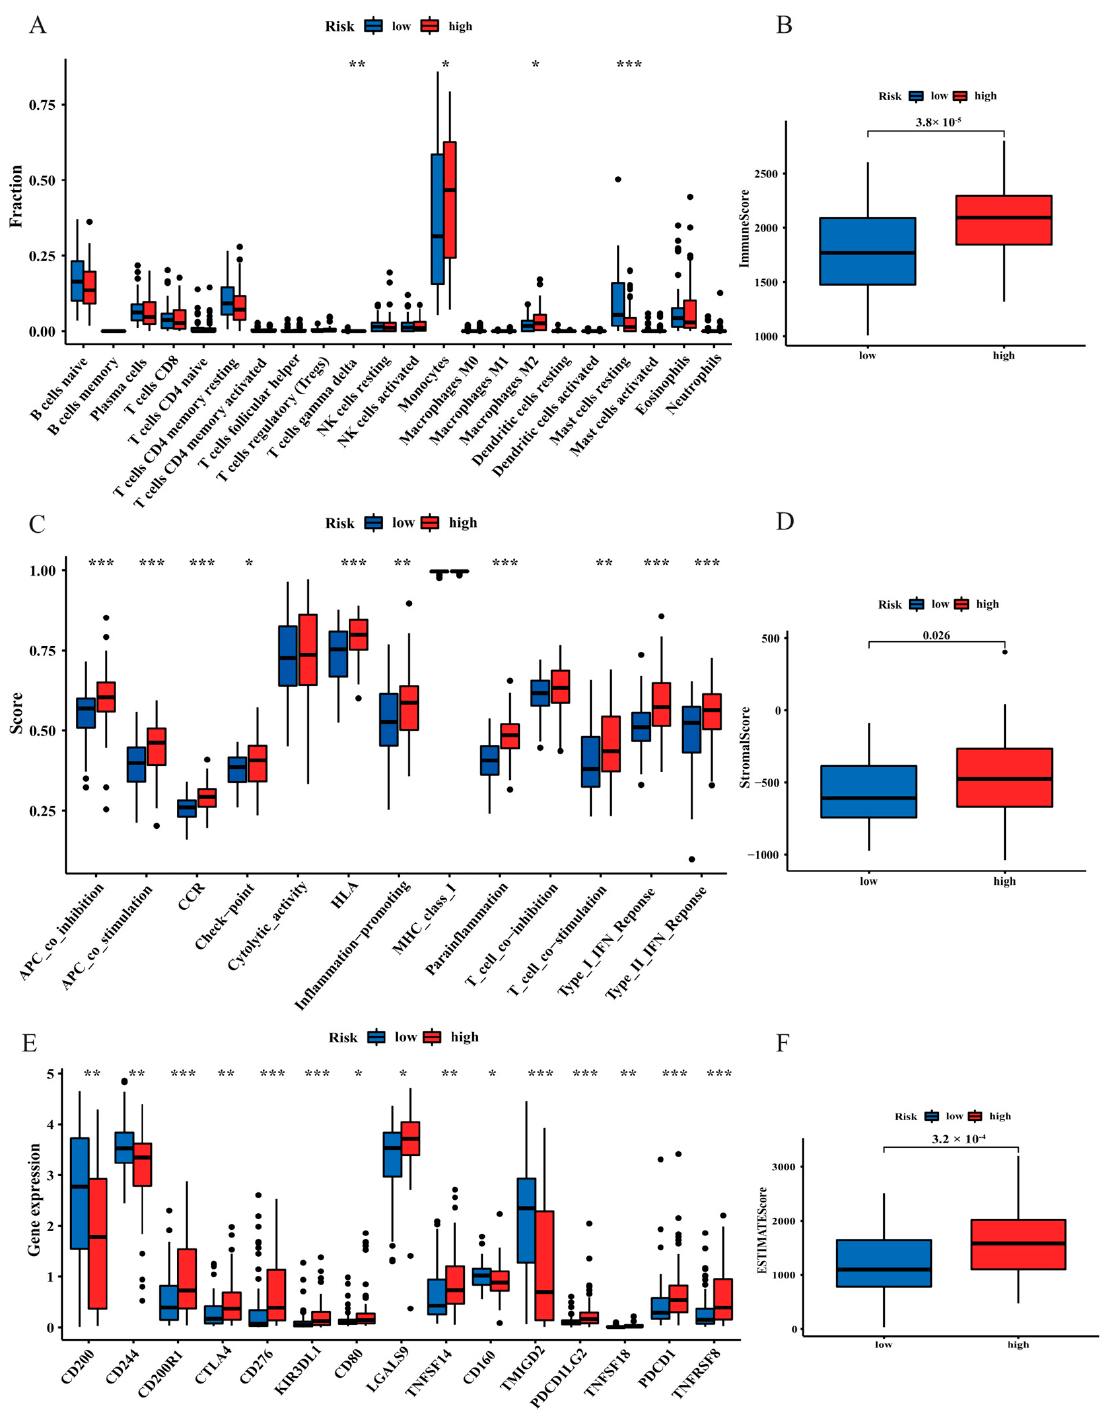
Figure 8 . Comparison of the tumour microenvironment (TME) and immune cell infiltration between the two risk groups. ( A ) Box plot of the fraction of 22 immune cells in the high- and low-risk group. ( B , D , F ) Immune score, stromal score, and ESTIMATE score between different risk groups. ( C ) Box plot of the scores of 13 immune-related functions in the high- and low-risk group. ( E ) Differences in the expression of 15 checkpoints in the two risk groups. * p < 0.05; ** p < 0.01; and *** p < 0.001.